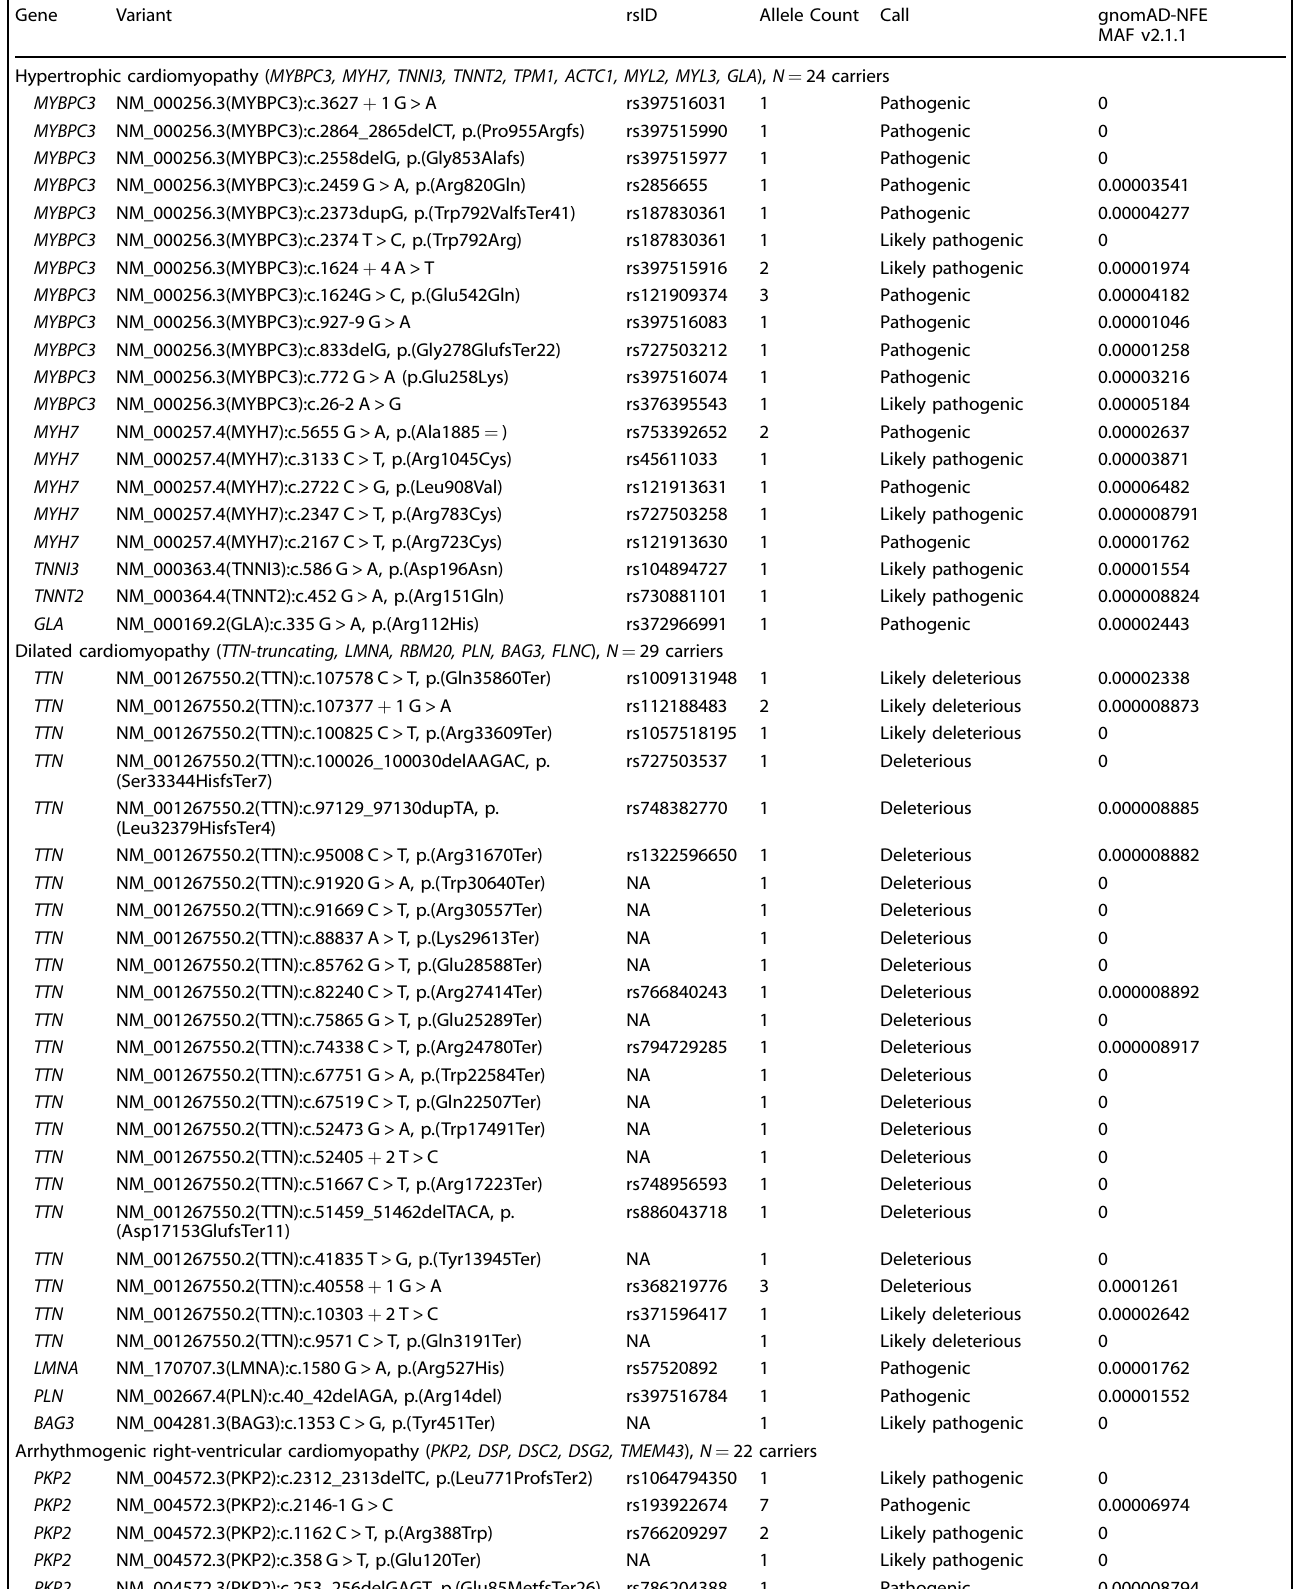
Table 3. Pathogenic or deleterious variants in genes associated with inherited cardiovascular disorders among 13,131 asymptomatic individuals aged 70 years and older without a history of cardiovascular